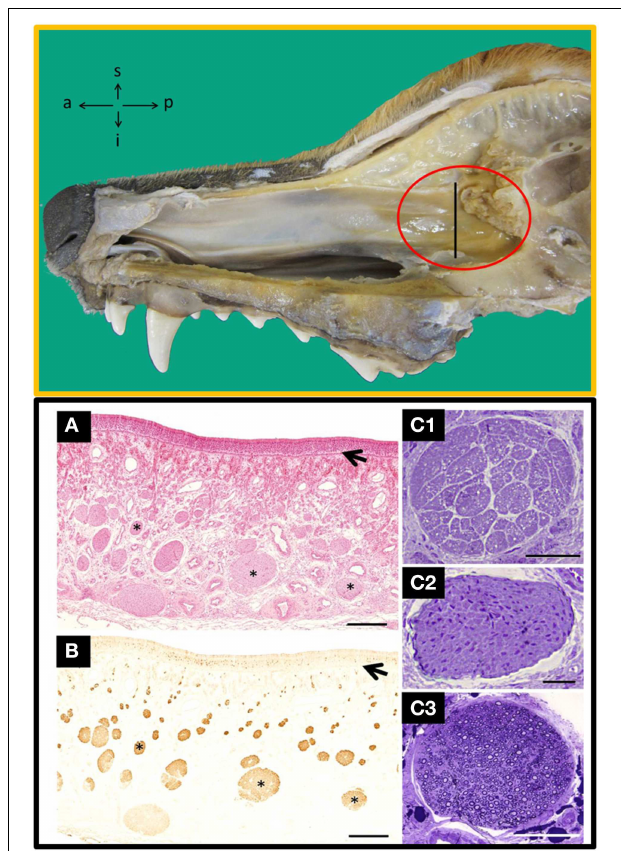
FIGURE 1 | Top: Inside view of the nasal cavity showing the nasal septum where the area of olfactory mucosa has the highest concentration of nerves bundles (red circle). a, anterior; i, inferior; p, posterior; s, superior. Bottom : Transverse sections of the nasal septum, at the level indicated by the perpendicular line in the TOP figure stained with haematoxylin-eosin (A) and anti-OMP (B) , a specific marker for olfactory tissue; arrows indicate the basal lamina and asterisks nerve bundles. Semithin transverse sections of nerves bundles likely to be found in the lamina propria from: unmyelinated olfactory nerves (C 1 ) , unmyelinated vomeronasal nerves (C 2 ) and branches of the myelinated trigeminal nerves (C 3 ) . Scale bars: (A,B) , 500 µ m; (C 1 –C 3 ) , 50 µ m. [Top and Bottom (A,B) , figures previously published in their original form or slightly adapted from Barrios et al. (2014). Bottom (C) , comes from a doctoral dissertation published by the Spanish Ministry of Education